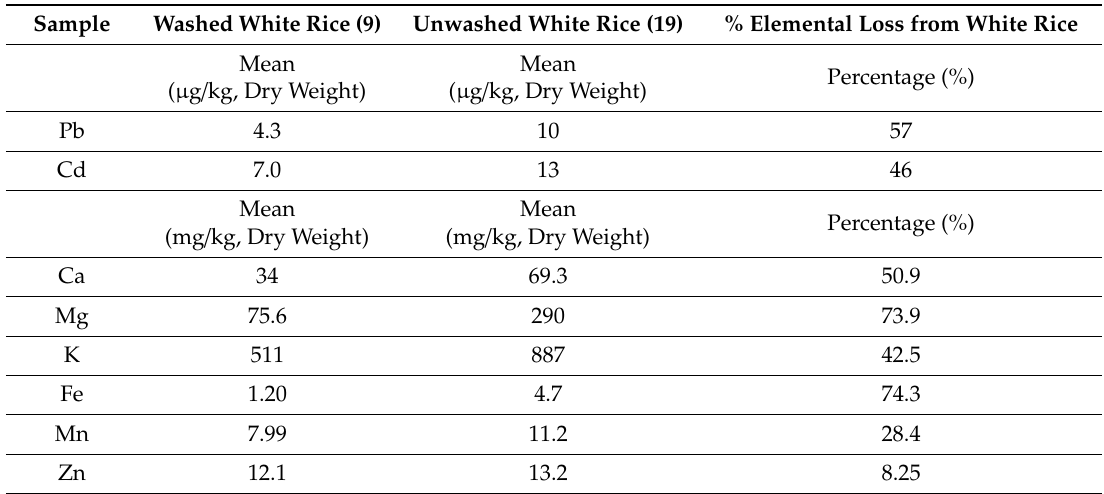
Table 2. Percentage elemental loss of toxic and essential elements from rinse-washed white rice.